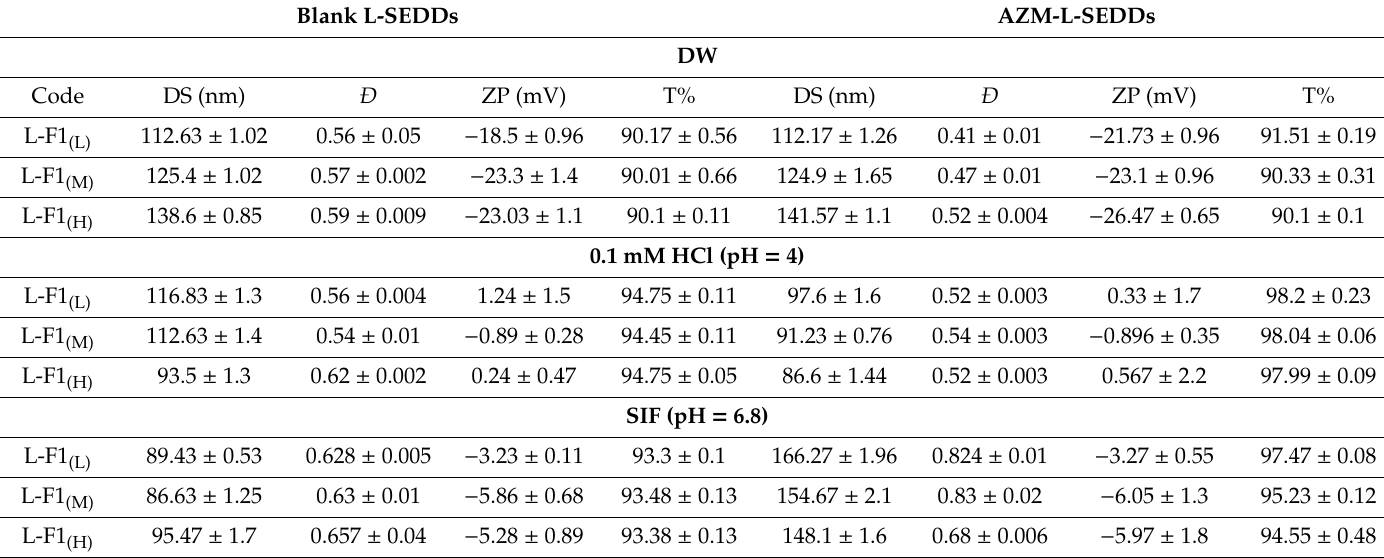
Table 4. Characterization of blank and AZM-L-F1 formulations at Capryol 90 ® oil concentrations of low, medium, and high analyzed in the three diluents. Mean ± SD, n =